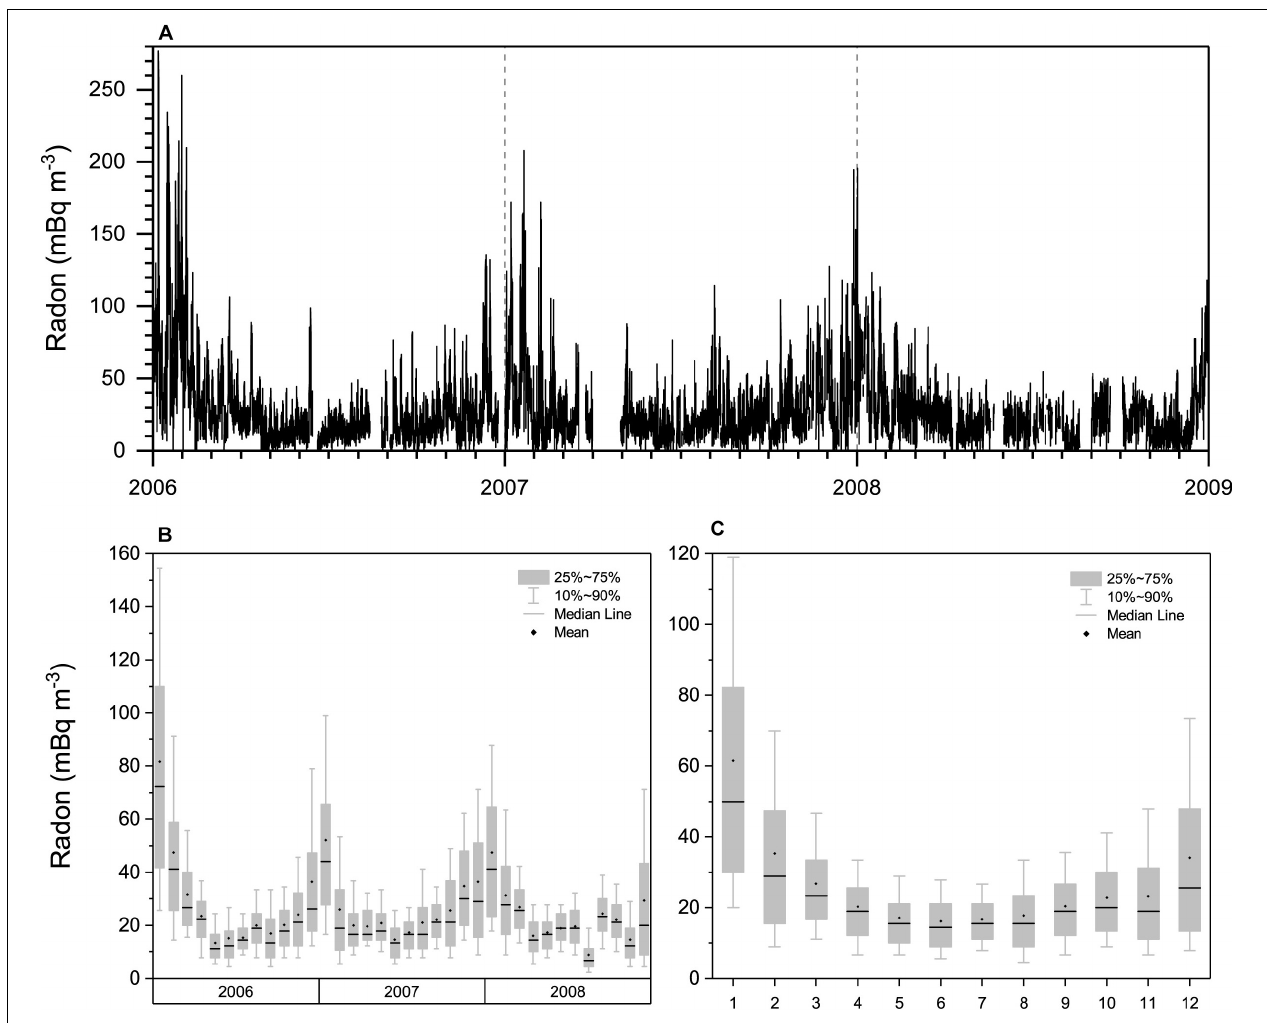
FIGURE 8 | (A) Hourly, and (B,C) monthly distributions of DDU radon concentrations between 2006 and 2009. Refer to key for distribution box-plot